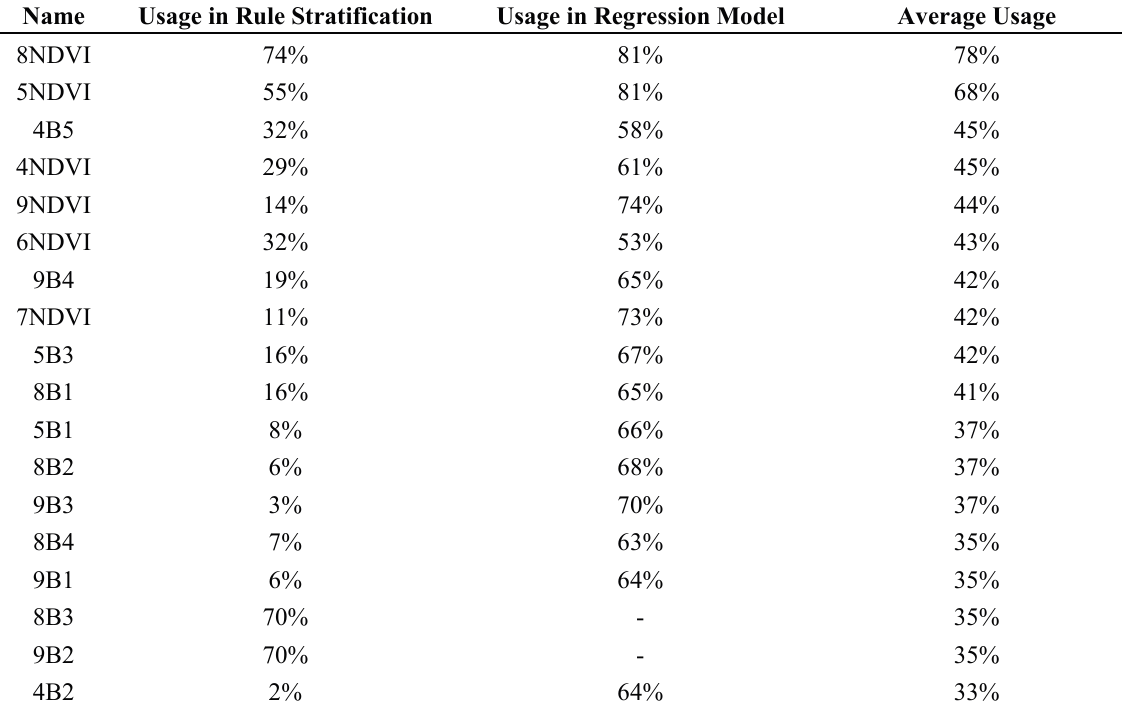
Table 2. Attribute usage in the rule-based piecewise regression GSN model. Name explanation: (1) the first character of the name represents the month (e.g., 4 represents April) and (2) B1–5 represents reflectance of the Landsat bands 1–5 (e.g., 4B5 means Landsat surface reflectance for April derived from band 5; 8NDVI means NDVI for